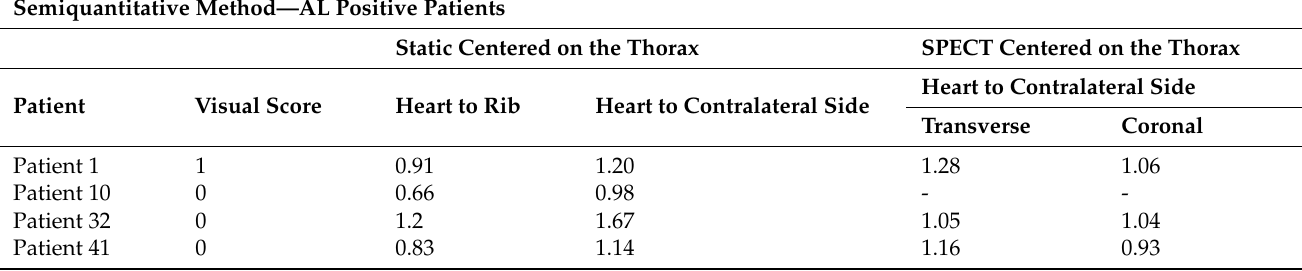
Table 10. Semiquantitative Method for AL positive patients.